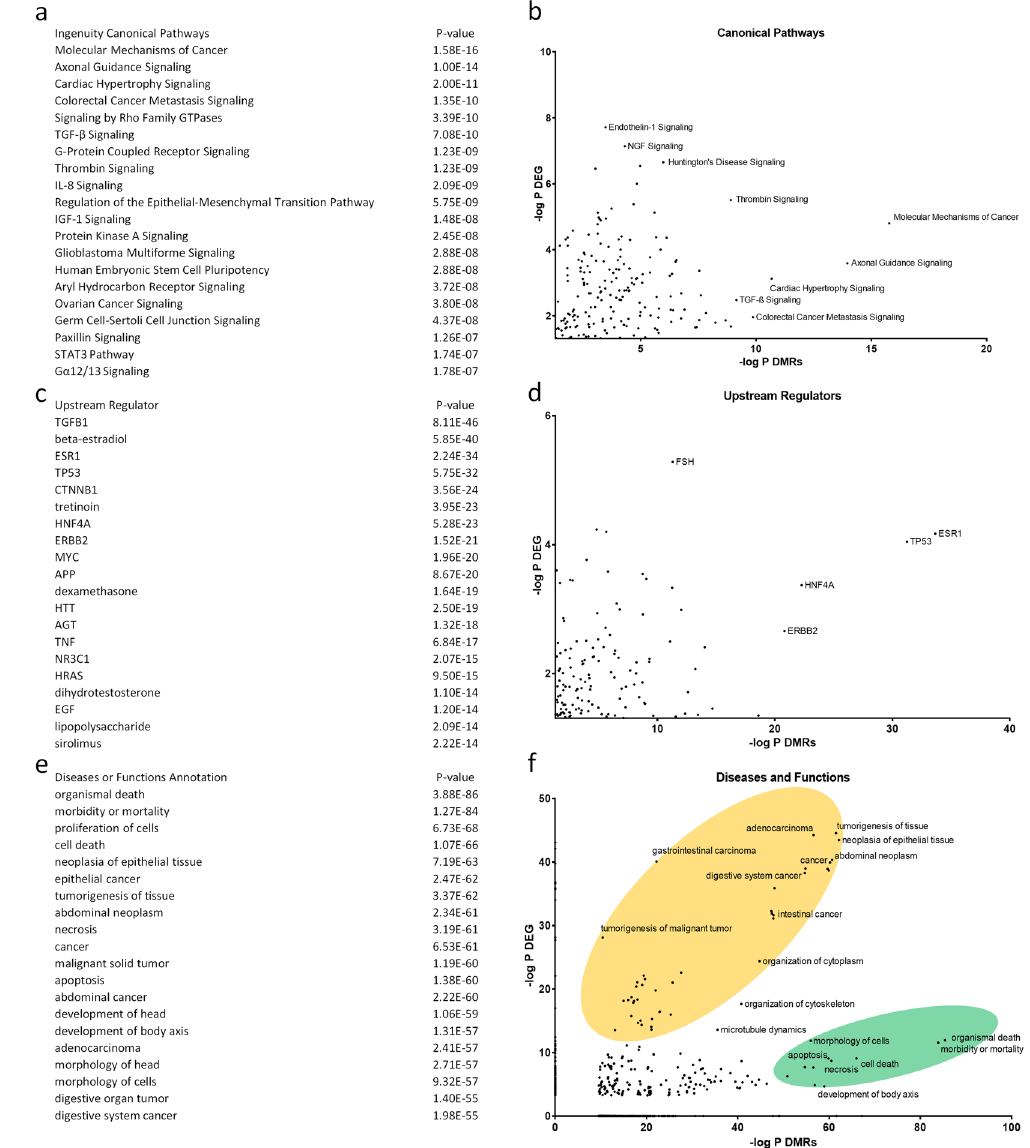
Figure 4. Correlation of overrepresentation between differentially expressed genes (DEGs) and differentially methylated regions (DMRs) following Ingenuity Pathway Analysis. ( a ) Top 20 list of DMR specific enriched canonical pathways. ( b ) Relationship between DEGs and DMRs enriched canonical pathways. ( c ) Top 20 list of DMR specific upstream regulators. ( d ) Relationship between DEGs and DMRs specific enriched upstream regulators. ( e ) Top 20 list of DMR specific diseases and functions. ( f ) Relationship between DEGs and DMRs specific disease lists (cancer: yellow; development and mortality: